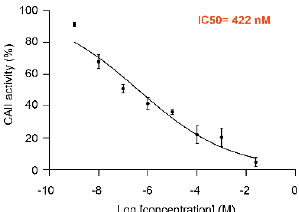
Figure 2. Dose-response curve and IC 50 value of CAII inhibition by actarit (IC 50 of 422 nM). Error bars represent the standard error of the mean of triplicate average values. Data were fit by non-linear regression (R 2 = 0.94138) and IC 50 values were determined using the equations Y = 100/(1 + 10^((LogIC 50 − X)*HillSlope)) where Y is the percentage of CAII activity relative to untreated samples, using GraphPad Prism 7.00 software.